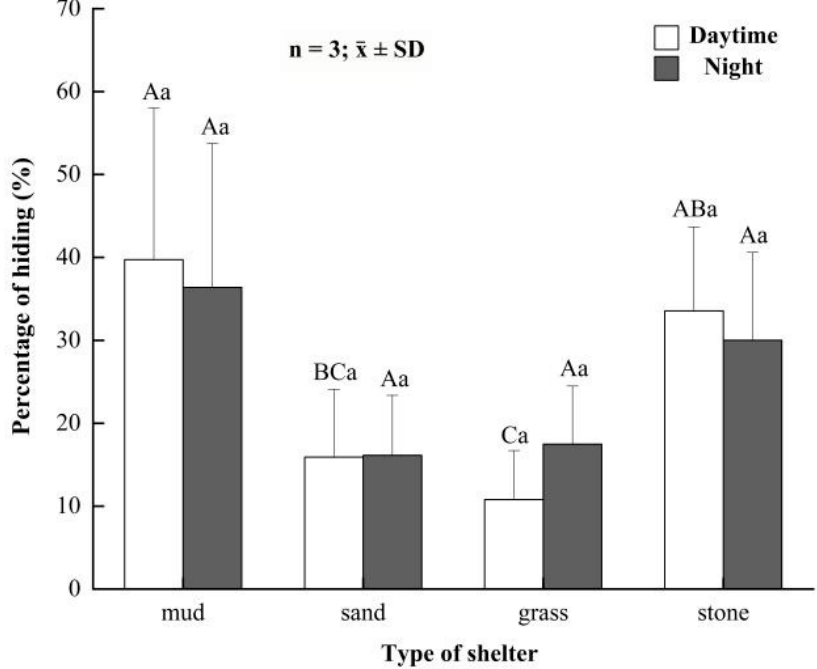
Figure 5. The hiding rate of button-sized Eriocheir sinensis in different shelters between daytime and night. Bars with same letters on the top indicate they have insignificant differences ( p > 0.05), and bars with different letters on the top indicate they have significant differences ( p < 0.05). Capital letters indicate the significance of hiding rates in different developmental stages, and lowercase let- ters indicate the significance of hiding and not hiding in the same stage.